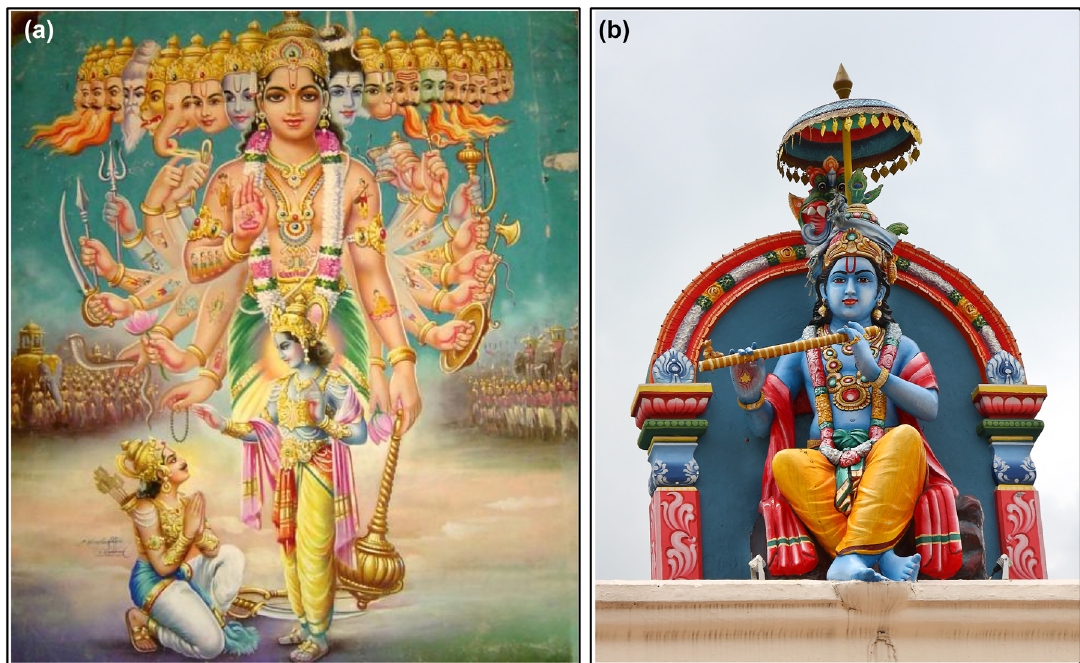
Figure 3: 2D [23] (a) and 3D [24] (b) representations of Krishna. In (a), it is represented the episode of Krishna proving prince Arjuna with help, advice and powers for the preparation of a battle (armies in the background).